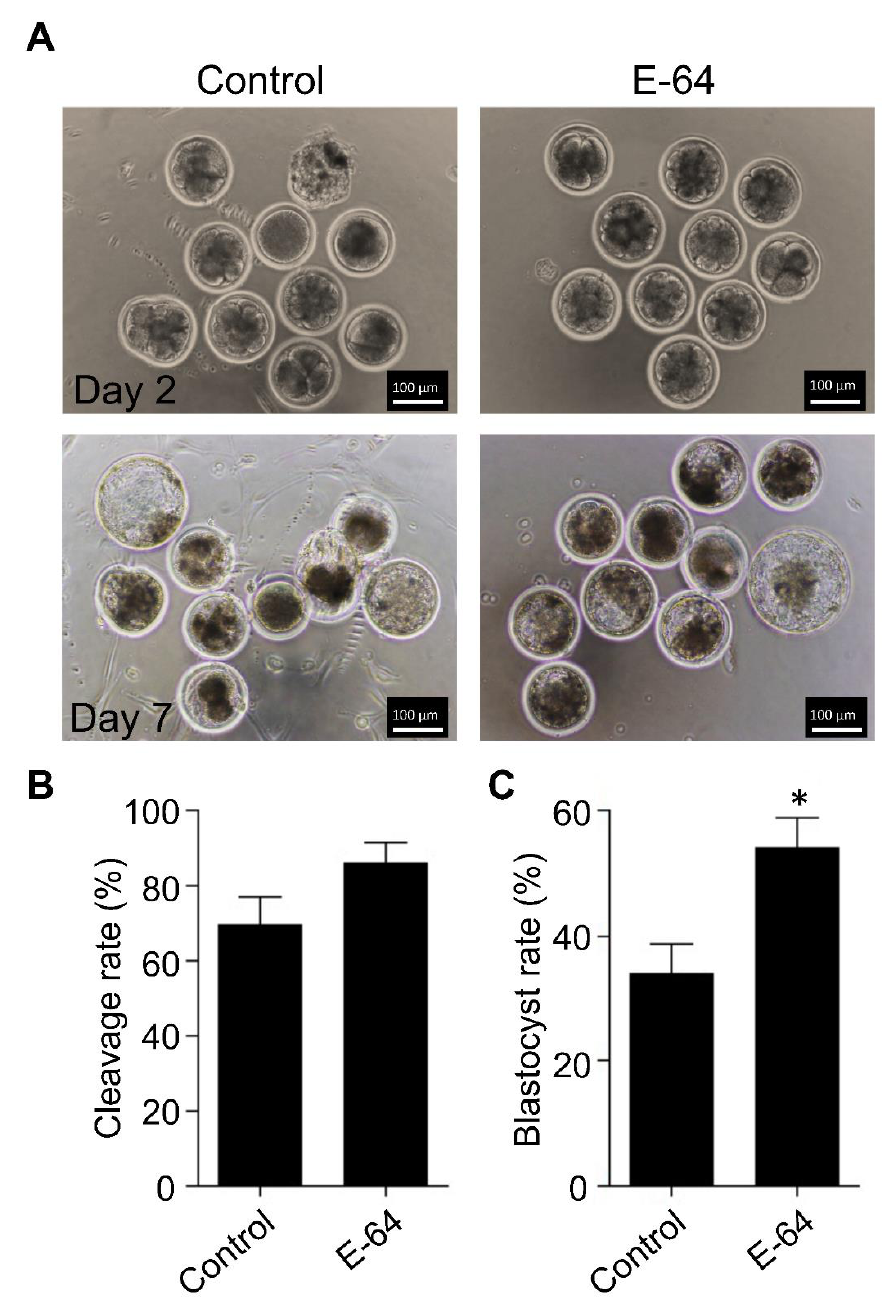
Figure 2. Effect of E-64 supplementation during in vitro maturation on the developmental compe- tence of ovum pick-up-derived immature oocytes. Bovine COCs were recovered from live animals using ultrasound-guided transvaginal ovum pick-up technique. Recovered COCs were in vitro ma- tured in the presence or absence of 1 µM of E -64. After in vitro fertilization, putative zygotes were cultured for 7 days. ( A ) Cleavage rate was evaluated on day 2 while the blastocyst rate was evalu- ated on day 7. Shown are representative images. ( B ) Quantifications of the cleavage rate. ( C ) Quan- tifications of the blastocyst rate. Total number of oocytes used is 98. The experiments were carried out five times. The data are expressed as mean ± SEM; Student’s t -test was used to analyze the data. Values with asterisks vary significantly, * p < 0.05.